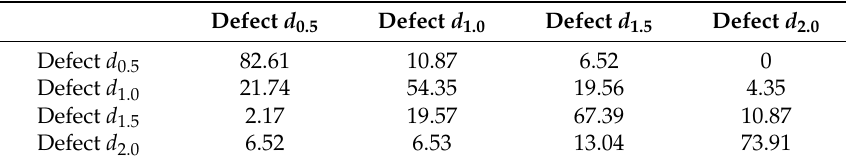
Table 4. Confusion matrix of the DCNN DEP (depth) [%].